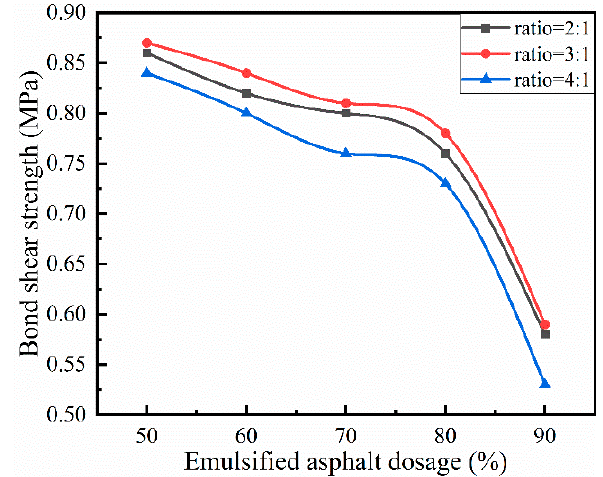
Figure 13. Bond shear strength of different dosage of epoxy emulsified asphalt.